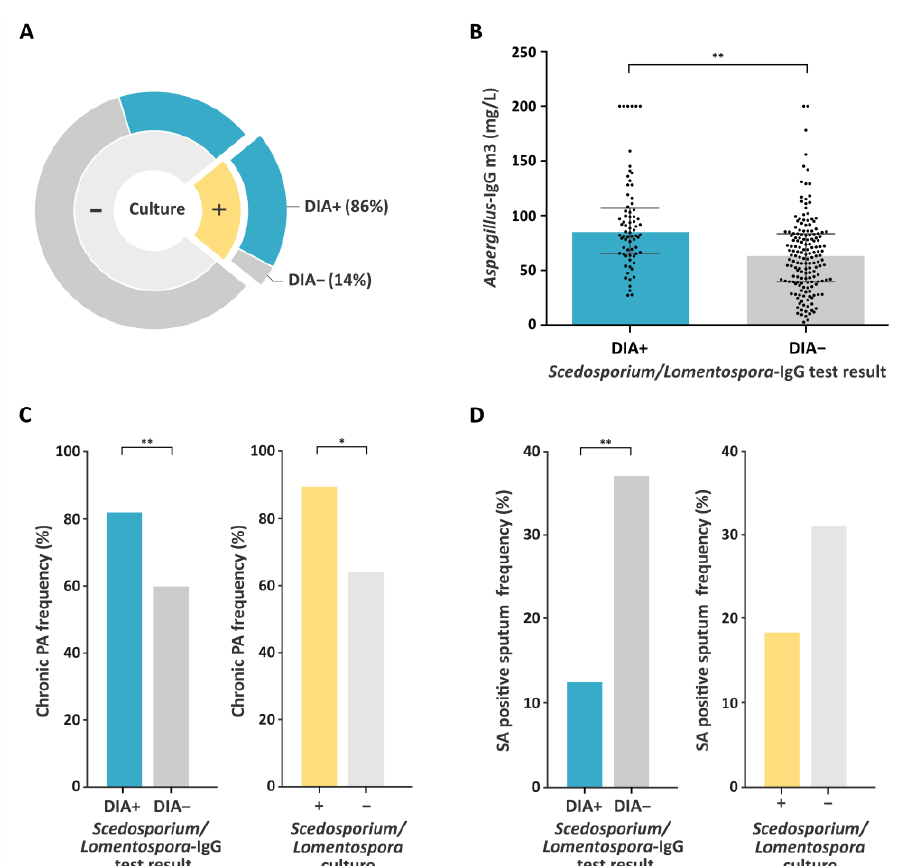
Figure 5. Association factors for positive Scedosporium / Lomentospora -IgG rapid test (DIA). Variables identified in univariate analysis and adjusted multivariate analysis as significantly associated with positive Scedosporium / Lomentospora -IgG: Frequency of DIA+ results in Scedosporium / Lomentospora positive cultures ( A ), Aspergillus IgG levels ( B ), chronic P. aeruginosa frequency ( C ) and S. aureus positive sputum frequency ( D ). Blue and yellow relate to DIA test result and Scedosporium / Lomentospora culture result, respectively. Dark and light grey relate to DIA negative and Scedosporium/Lomentospora negative culture, respectively. PA: P. aeruginosa , SA: S. aureus . * p < 0.05; ** p < 0.001.